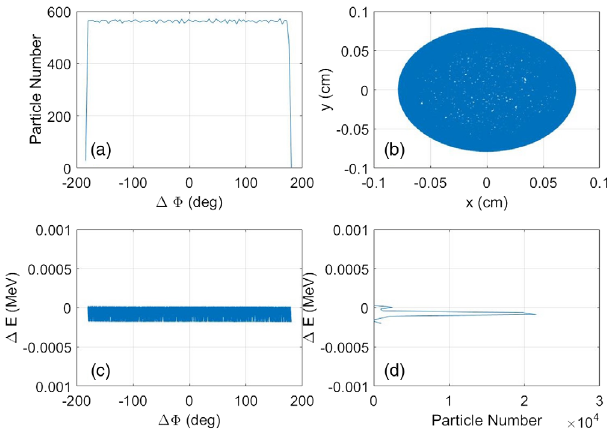
FIG. 9. T-Step input electron beam parameters. (a) longitudinal phase distribution in degrees; (b) beam transverse spot size in cm; (c) beam longitudinal phase-space (energy vs phase); (d) beam energy spectrum in